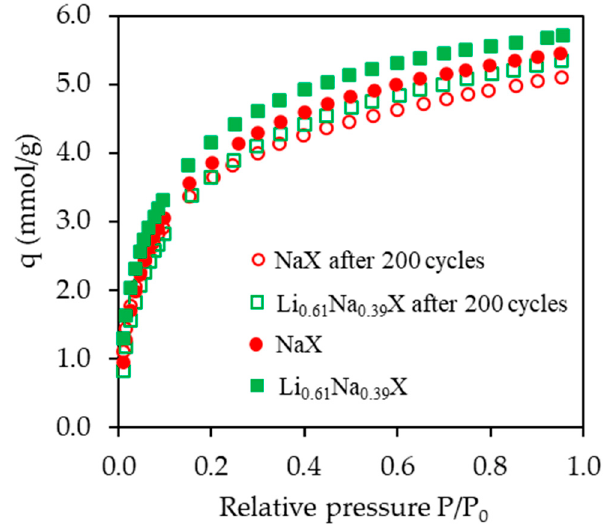
Figure 14. CO 2 adsorption isotherms at 298 K of Li 0.61 Na 0.39 X and NaX samples before and after 200 adsorption/desorption aging cycles.